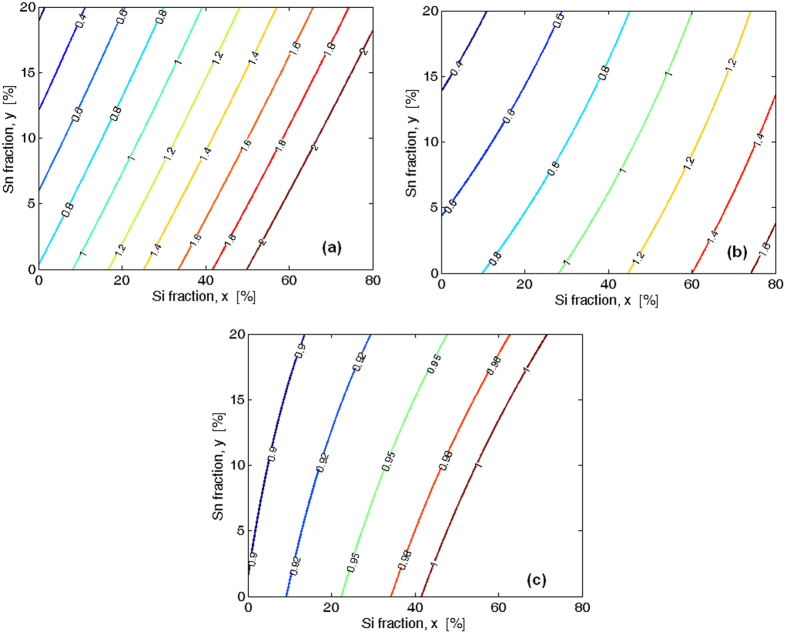
Ge1−x−ySixSny conduction-band energies of unstrained alloy in eV as a function of the Si and Sn fractions; (a) Γ point. (b) L point. (c) X point.